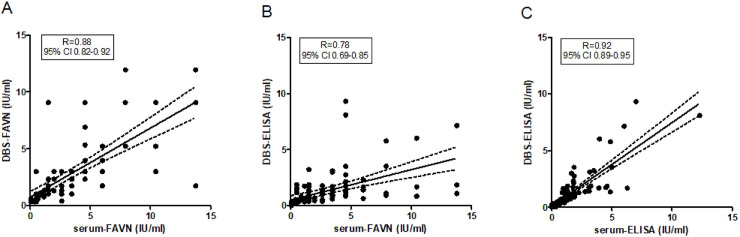
Correlation of quantitative results of the FAVNt and the Platelia-II ELISA performed on DBS and serum.Panel A shows the correlation between the RVNA titer of DBS-FAVNt and the RVNA titer of undiluted serum measured with the FAVNt. Panel B shows the antibody titer of DBS-ELISA compared to the RVNA titer of undiluted serum measured with the FAVNt. Panel C shows the antibody titer of DBS-ELISA compared to the antibody titer of serum-ELISA. R represents the Spearman correlation coefficient. CI is confidence interval. Dashed lines represent the of 5% confidence bands of the best fit line (represented by solid lines).